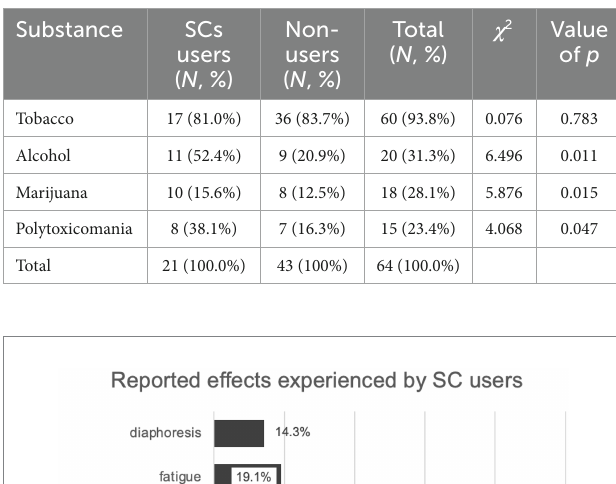
TABLE 3 Past and current substance use.